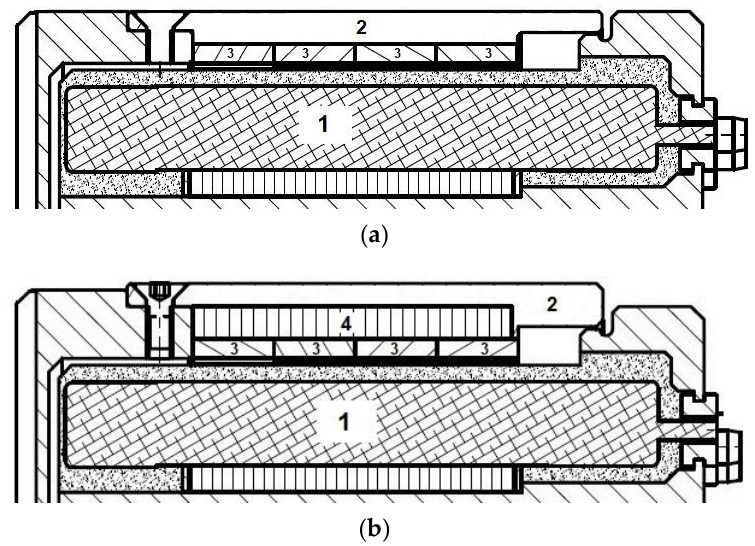
Figure 1. ( a ) Cross-section of a fragment of motor with a solid rotor; ( b ) cross-section of a fragment of motor with a laminated rotor, where 1 — stator winding, 2 — solid rotor yoke, 3 — permanent magnets, 4 — laminated rotor yoke. Table 1. Basic data for the analyzed motor models.